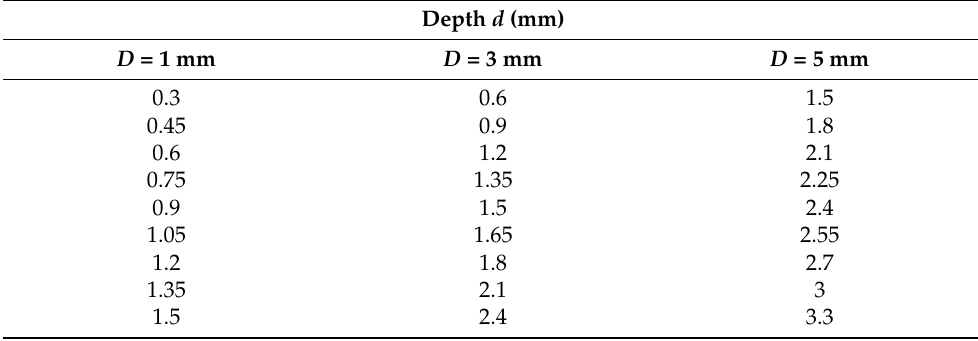
Table 2. Sphere-like defects in 3D printed PAL samples.